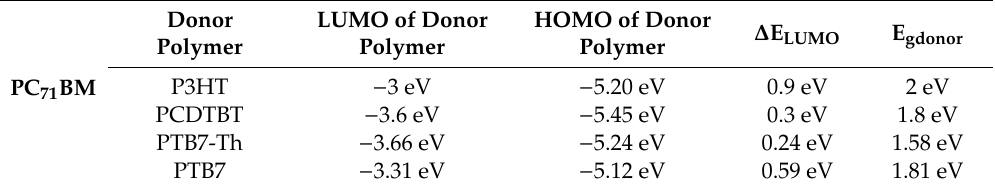
Table 2. Conjugated polymers typically used as electron donors with PC 71 BM as the electron acceptor in organic solar cells. Included are the energy levels of the HOMO and LUMO levels, the ∆ E LUMO and the E g value of each donor polymer.